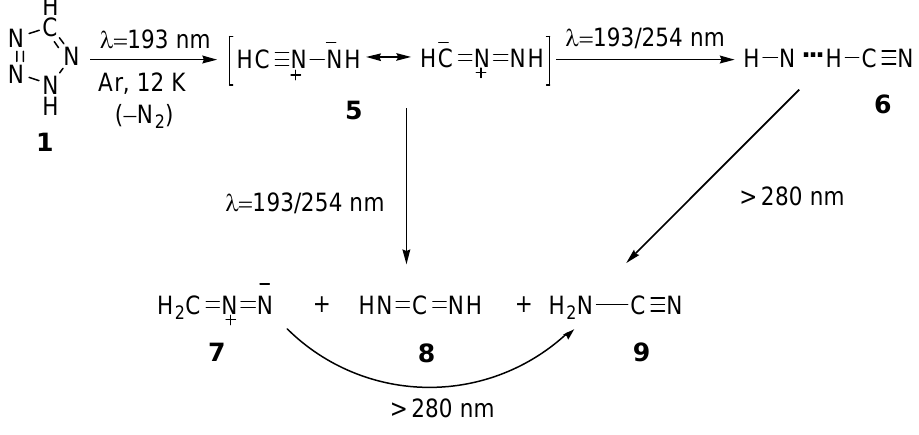
Scheme 1. Photodecomposition of matrix-isolated unsubstituted